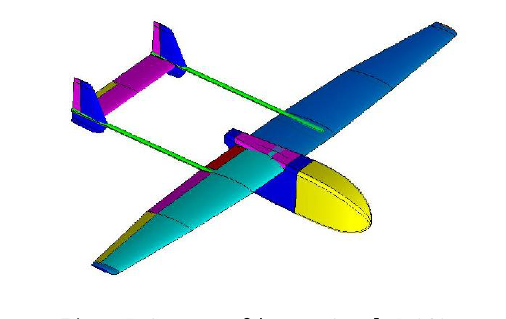
Figure 7. Concept of the new Carolo P 360